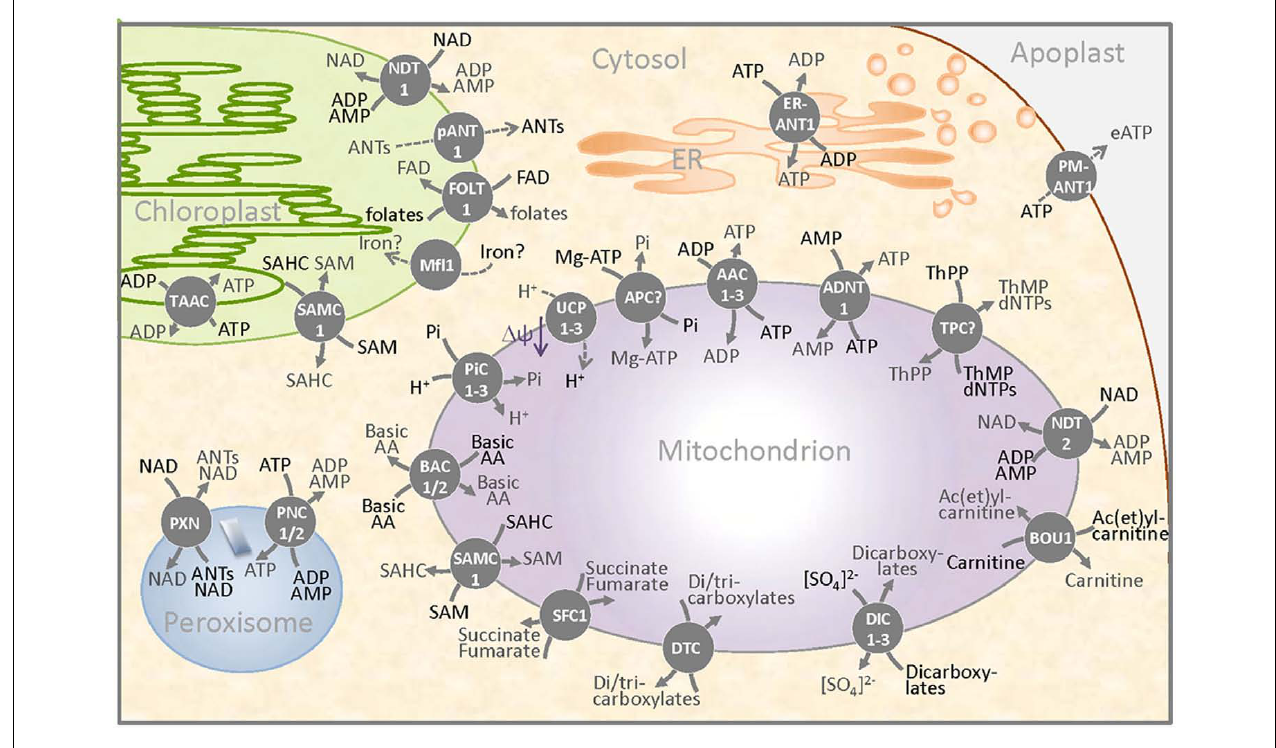
FIGURE 2 | Schematic overview of a plant cell detail presenting the occurrence of MCF carriers in membranes of different compartments. MCF proteins were identified in the inner membrane of mitochondria and plastids, in the thylakoids, in the endoplasmic reticulum (ER), in peroxisomes, and in the plasma membrane (separating the cytosol and the apoplast).Three ADP/ATP carriers (AAC1–3), the ATP/AMP carrier (ADNT1), putative ATP–Mg/Pi carriers (APC?), and the NAD/adenine nucleotide exchanger mediate the passage of ATP, ADP, AMP, or of the adenylated cofactor NAD across the inner mitochondrial membrane.The mitochondrial transport of carboxylates is mediated by three dicarboxylate carriers (DIC1–3), by